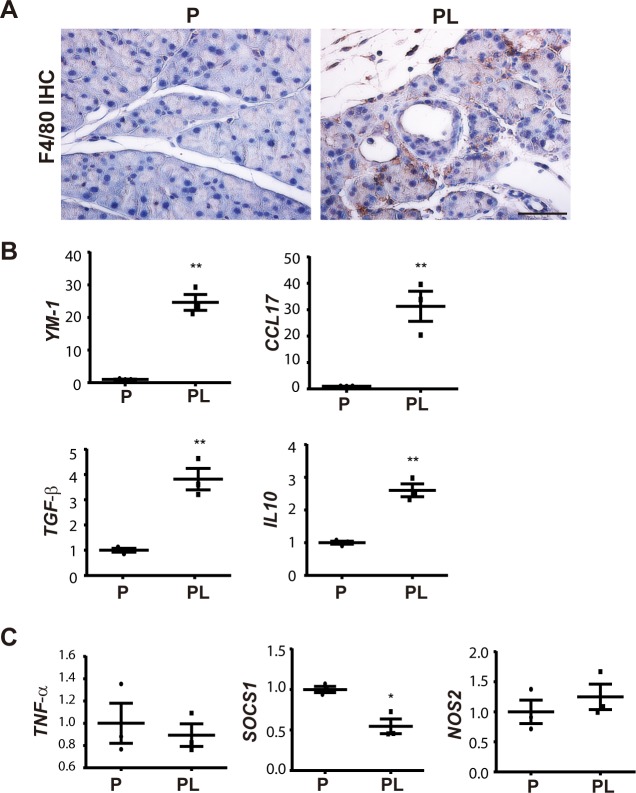
Loss of Lats1/2 induces M2 macrophage polarization.P and PL mice were treated with 180 mg/kg/d of TAM for 5 consecutive days; cells were isolated from both groups 4 days later (n = 3). (A) F4/80 IHC staining in P and PL mice on Day 4 after TAM injection. (B) M2 macrophage-specific genes Ym-1, Ccl17, Tgf-β and IL10 were elevated in sorted macrophages of PL mice. (C) M1 macrophage-specific genes Tnf-α, Socs1, and Nos2 were not significantly changed. **P < 0.01, *P < 0.05. Underlying numerical values can be found in S1 Data. IHC, immunohistochemistry; LATS1, large tumor suppressor 1; P, control; PL, double knockout; TAM, tamoxifen.